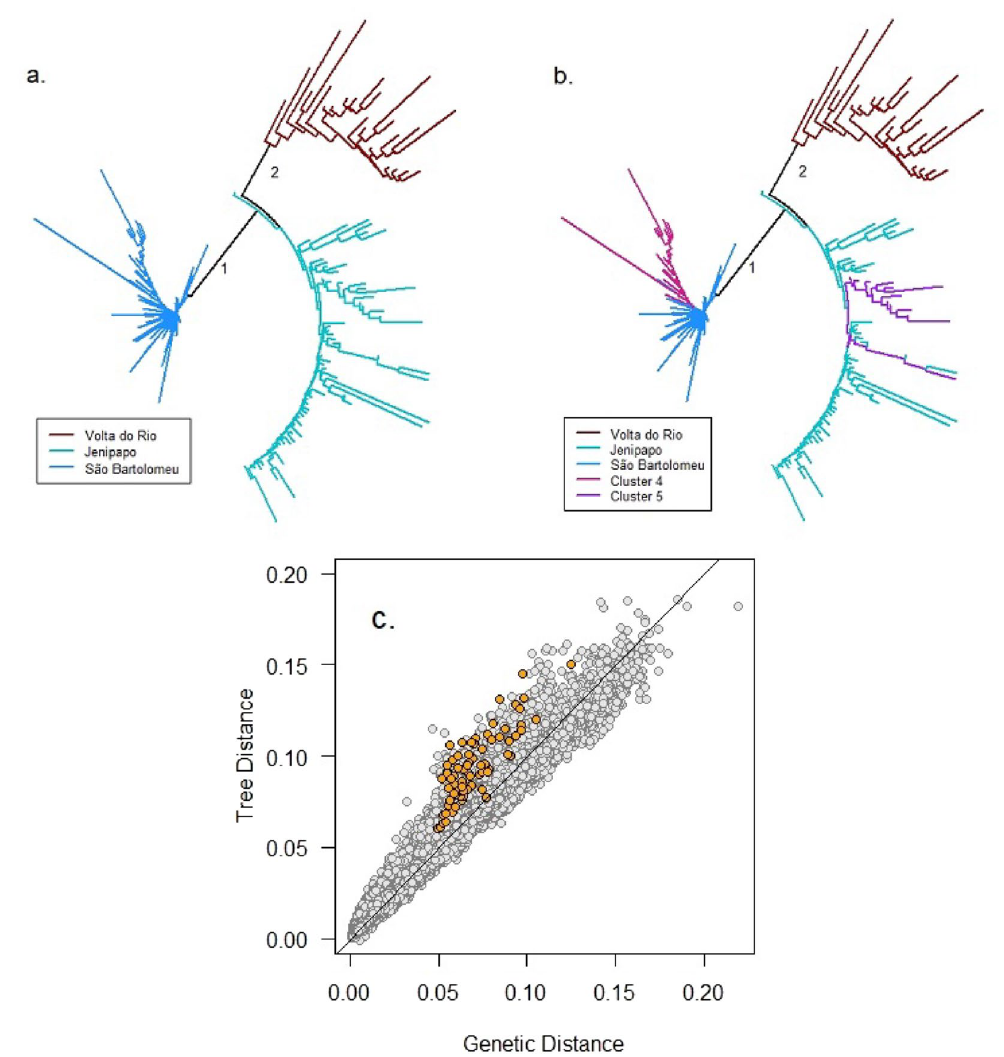
Figure 3. ( a ) Fan plot of the neighbor-joining tree with tips labeled according to communities. ( b ) Fan plot of the neighbor-joining tree with tips labeled according to results for K-means cluster analysis with K = 5 . ( c ) Genetic distances computed as the sum of branch lengths on the neighbor-joining tree plotted against genetic distances computed directly from allele frequencies. The orange-filled points indicate comparisons between infrapopulations in Cluster 4 with those in Cluster